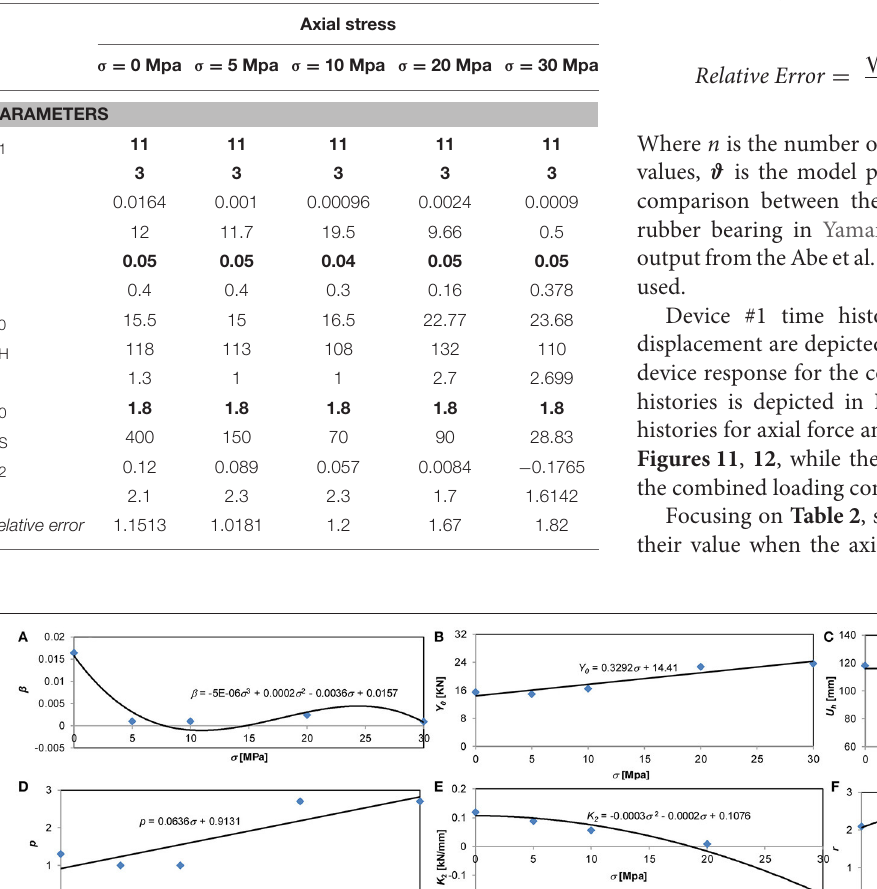
TABLE 5 | Super-set of optimal parameters.